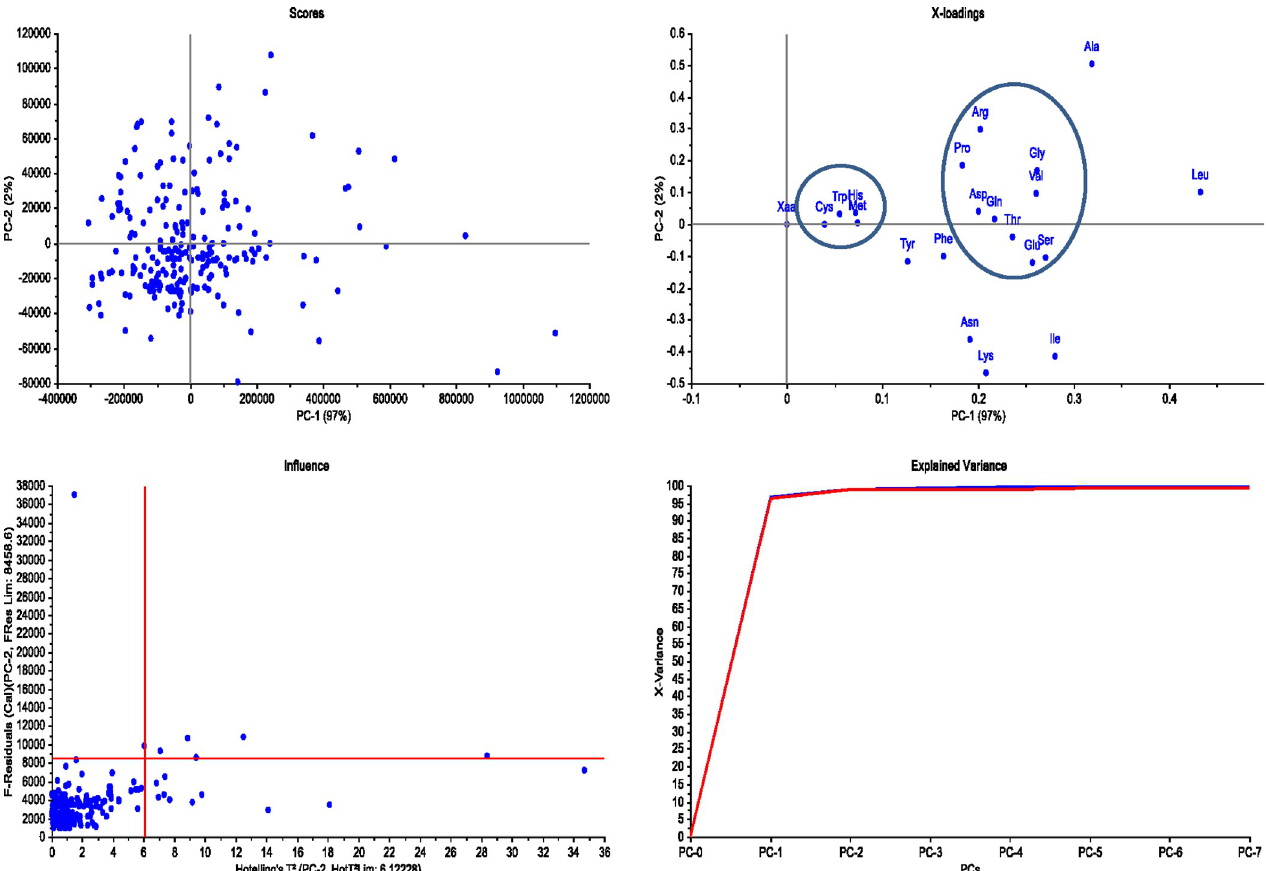
Fig 5. Principal component analysis (PCA) of amino acid composition of cyanobacterial proteome. The photograph was generated using Unsramber software version 7.